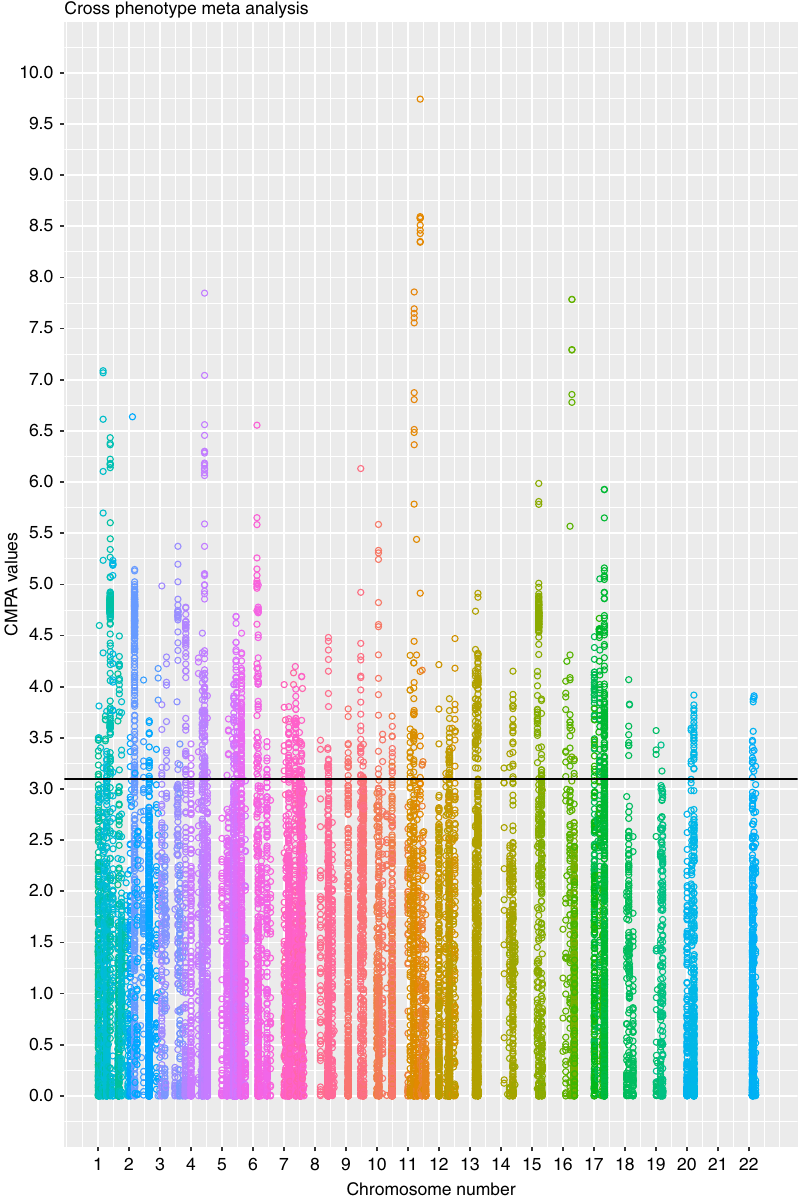
Fig. 4 Cross phenotype meta-analysis of murine genes without prior link to metabolism. SNPs are on the x -axis ordered as per chromosome and the CPMA values (log transferred) are on the y -axis. The chromosomes are shown in different colors. Each column represents the genes and SNPs stacking vertically. The higher the CPMA measure, the higher the signi fi cance of SNPs across different phenotypes. SNPs above CPMA = 3.1 were considered to have a signi fi cant link to the disease